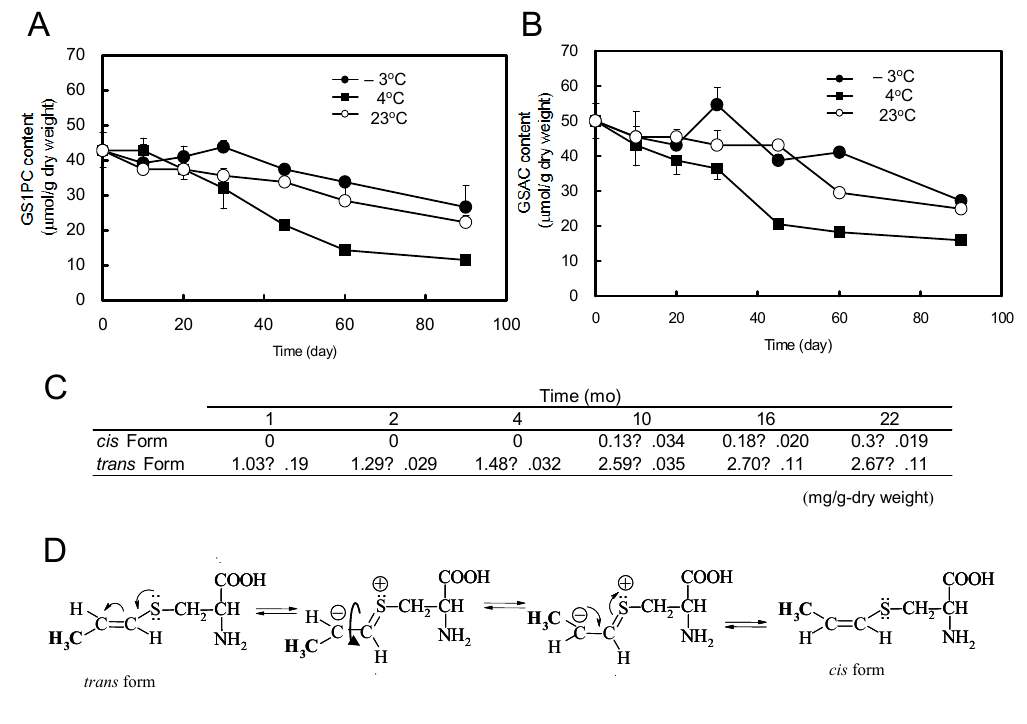
Figure 3. Changes of sulfur-containing compounds in raw garlic and AGE. ( A ) Changes of trans -GS1PC content in raw garlic stored at − 3 ◦ C, 4 ◦ C and 23 ◦ C; ( B ) Changes of GSAC content in raw garlic stored at − 3 ◦ C, 4 ◦ C and 23 ◦ C; ( C ) Changes of trans -S1PC and cis -S1PC content in aged garlic extract during the aging period. Values are mean ± SD ( n = 3); ( D ) Putative production mechanism of cis -S1PC through isomerization of the trans -form during aging process. Illustration is drawn based on literatures reports